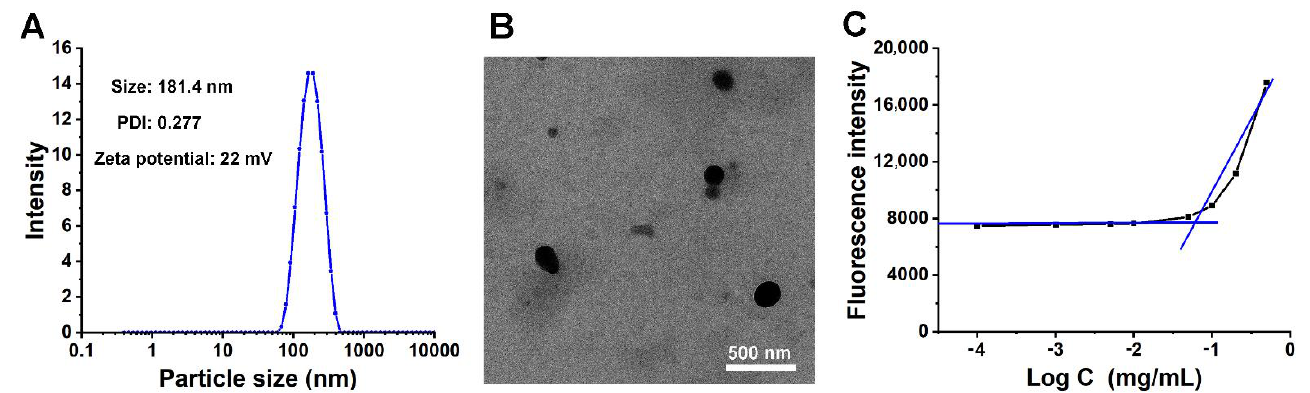
Figure 2. Characterization of GT-ss-CPT NPs. ( A ) Particle size of GT-ss-CPT NPs measured by DLS. ( B ) TEM image showing the morphology of GT-ss-CPT NPs. ( C ) Emission intensity (λ = 580 nm) of Nile red in an aqueous solution of GT-ss-CPT NPs with different concentrations.